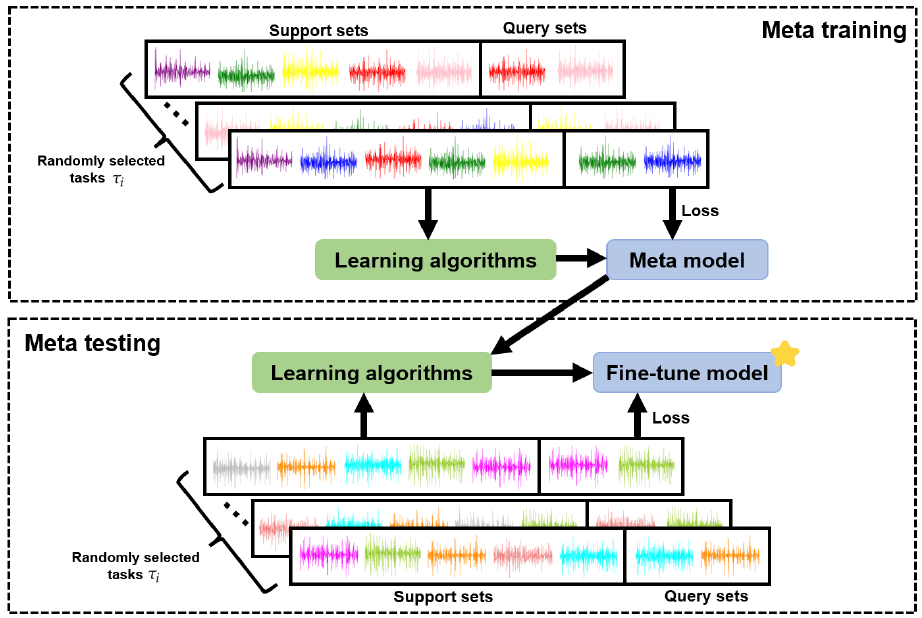
Figure 8. Specific block diagram of MAML framework in our work. The colorful lines represent the sEMG signals used for training and verification after windowing. The yellow star represents the model for new